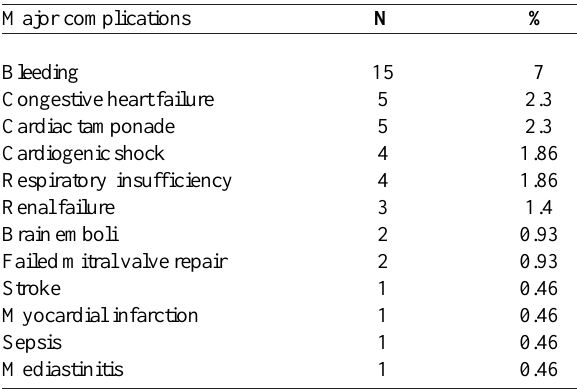
Table 3. Postoperative